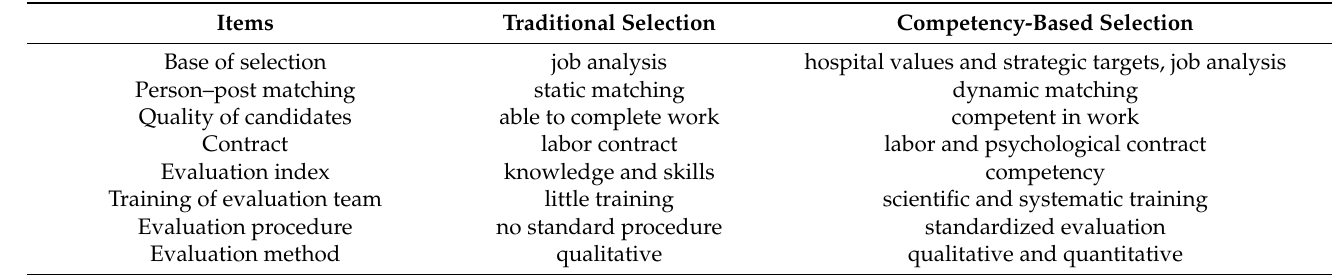
Table 6. Comparison of traditional selection and competency-based